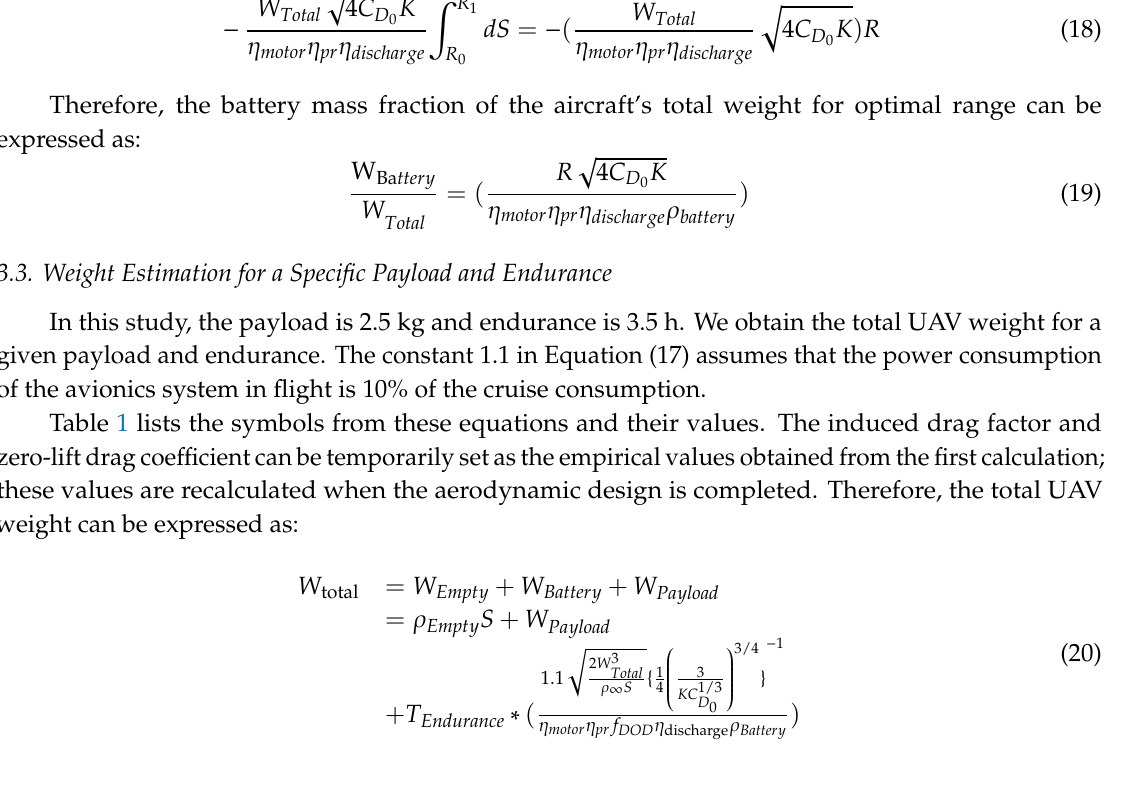
Table 1. Symbols and their values for weight estimation for a specific payload and